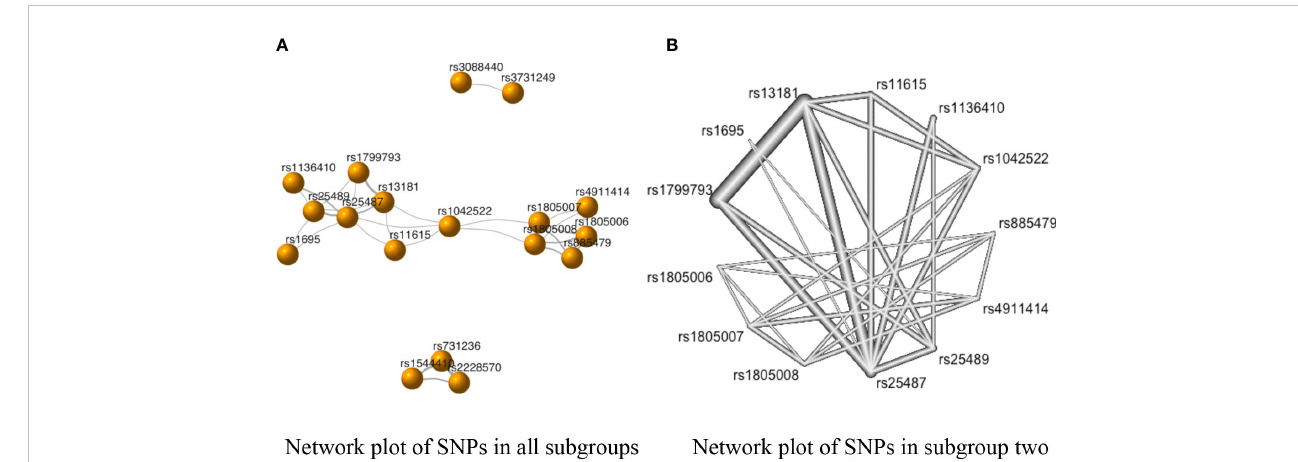
FIGURE 3 The network evidence plots of single nucleotide polymorphisms (SNPs) in the allele model ( A vs. B ). (A) Network plot of SNPs in all subgroups in the allele model; (B) Network plot of SNPs in subgroup two of the allele